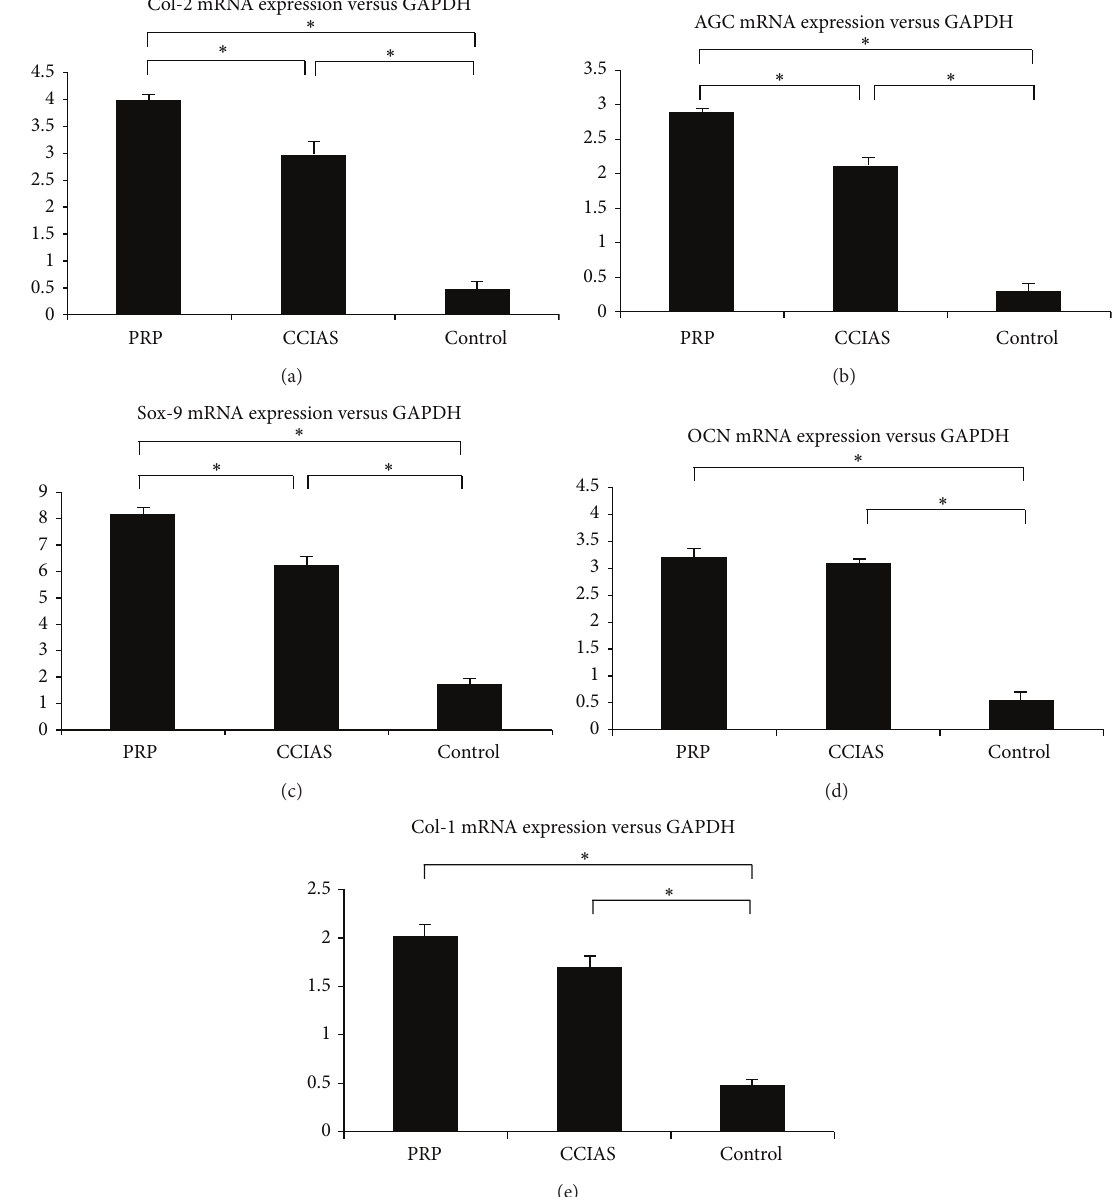
Figure 5: Quantitative analysis of Col-2 (a), AGC (b), Sox-9 (c), OCN (d), and Col-1 (e) gene expression. Statistically significant differences were found by one-way ANOVA in all five genes. ∗ 𝑃 < 0.05 , with a statistical significance between two